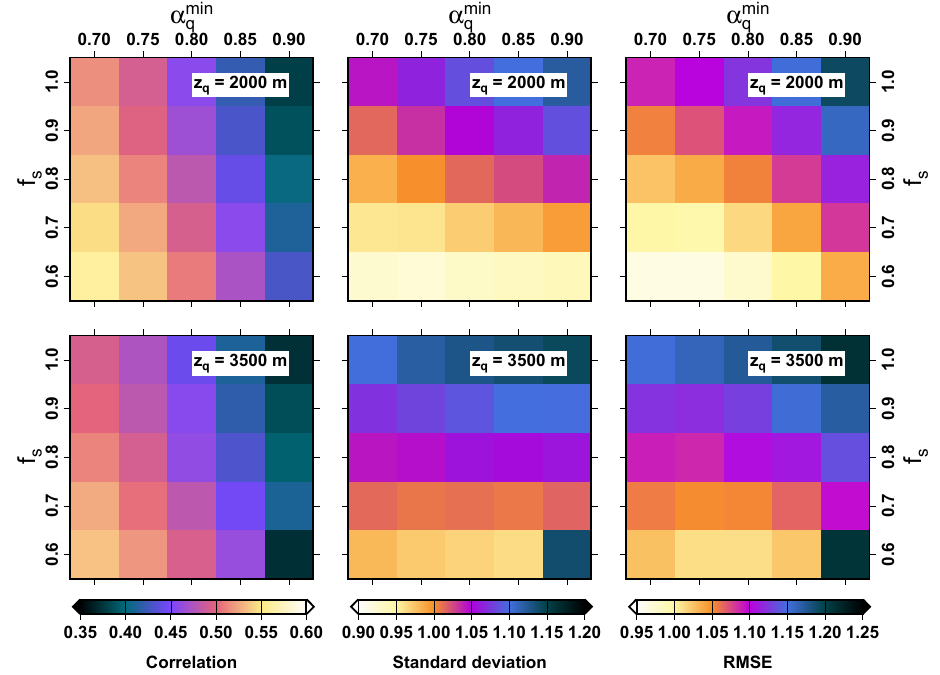
Figure 11. Correlation, normalized standard deviation and normalized root mean square error computed from annual mean precipitation as a function of the parameter values for the downscaling experiments. The normalization is done by dividing the modelled metric (either standard deviation or root mean square error) by the standard deviation in the